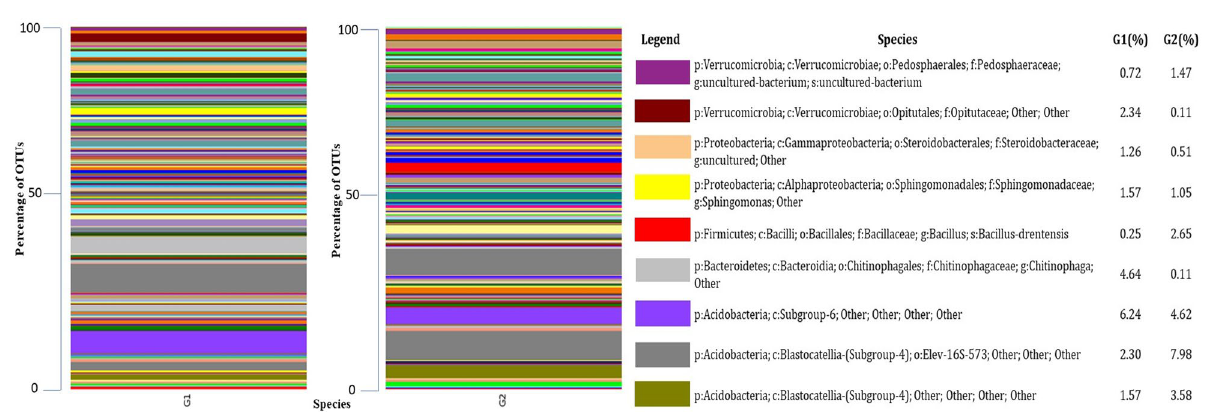
Figure 6. Comparative microbiome (Species) analysis of organic (G1) and conventional (G2) treated mango orchards soil by using metagenomic (V3 and V4 regions)